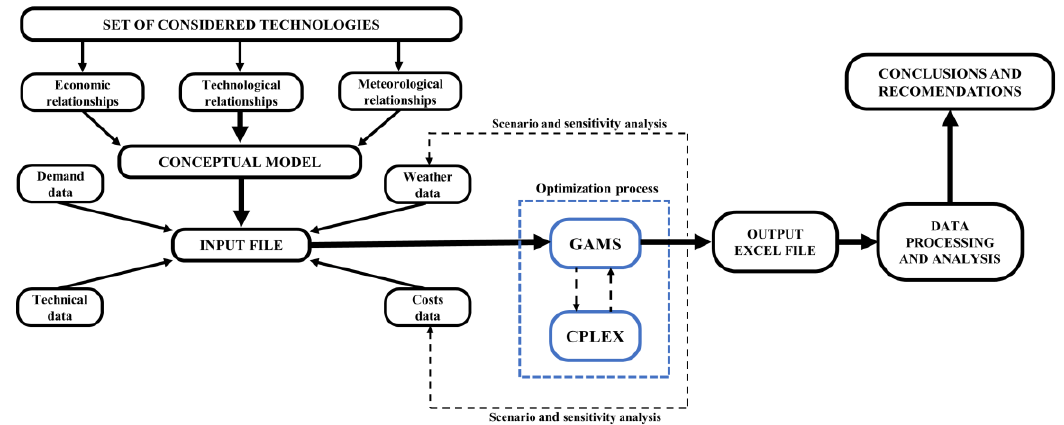
Figure 4. Flowchart of the optimization framework.